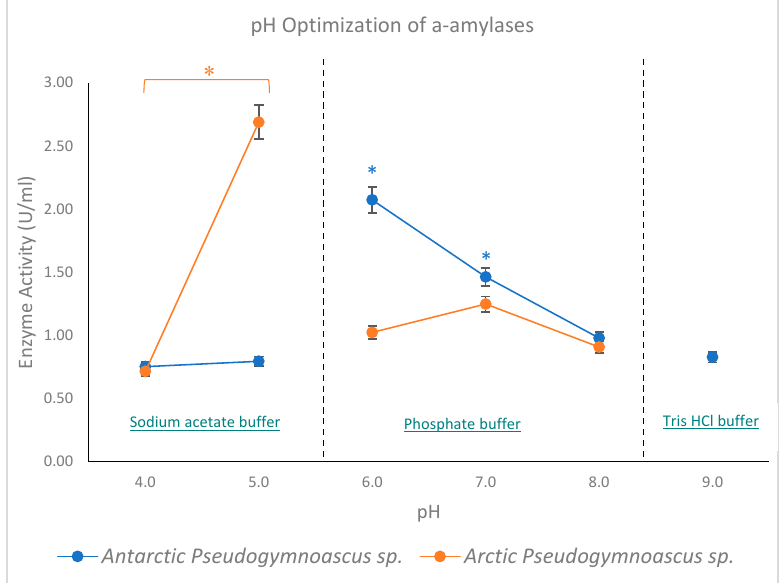
Figure 2. pH optimization using different buffers for α -amylase obtained from Antarctic Pseudogym- noascus sp. and Arctic Pseudogymnoascus sp. (* p < 0.05).